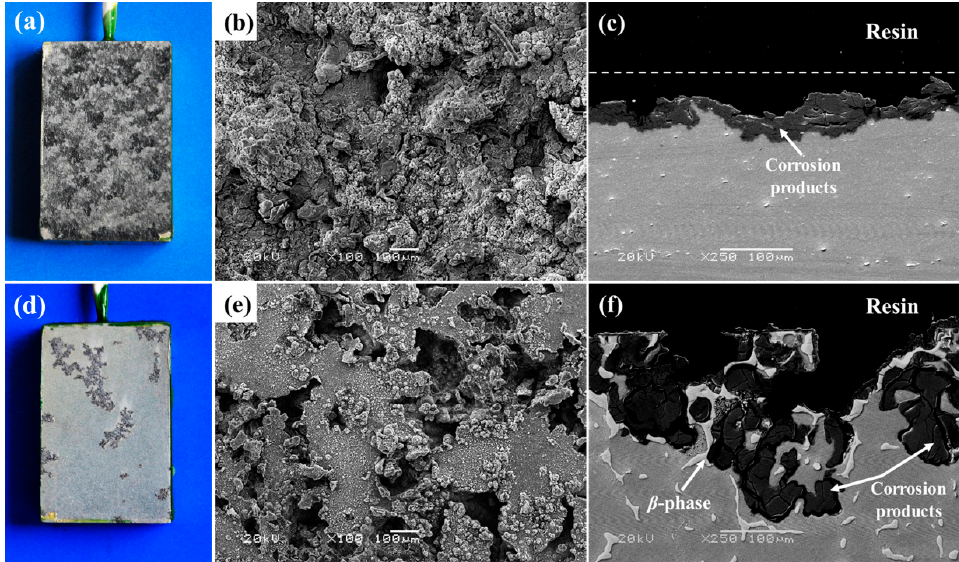
Figure 6. Photographs, surface and cross-section morphologies of the uncoated AZ31 ( a – c ) and AZ91 ( d – f ) alloys after 48 h immersion in 0.1 M NaCl solution. ( b , c , e , f ) are SEM images.